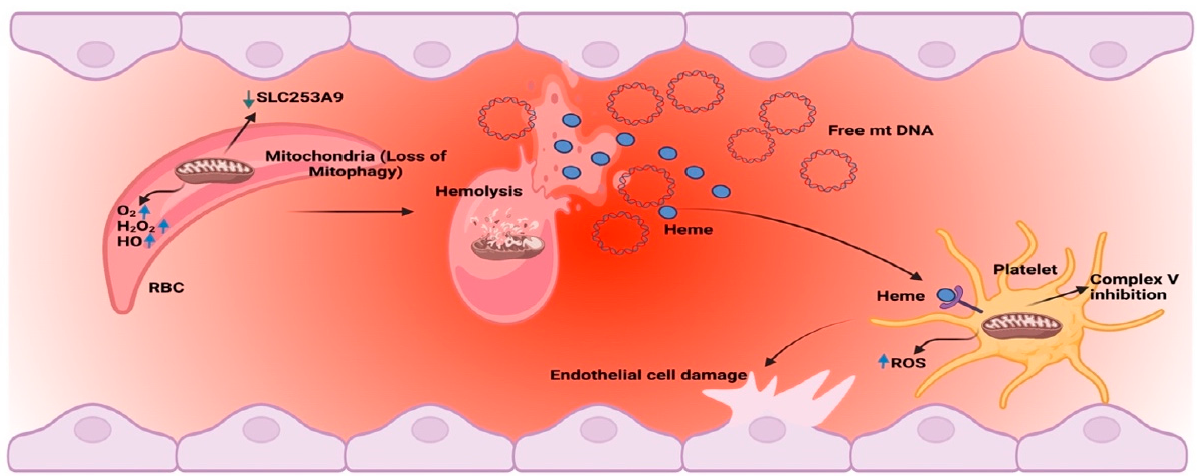
Figure 1. The mitochondrial dynamics and energetics are impaired in SCD, and are indicated by mitochondrial retention in RBCs, increased oxidative stress, and free circulating